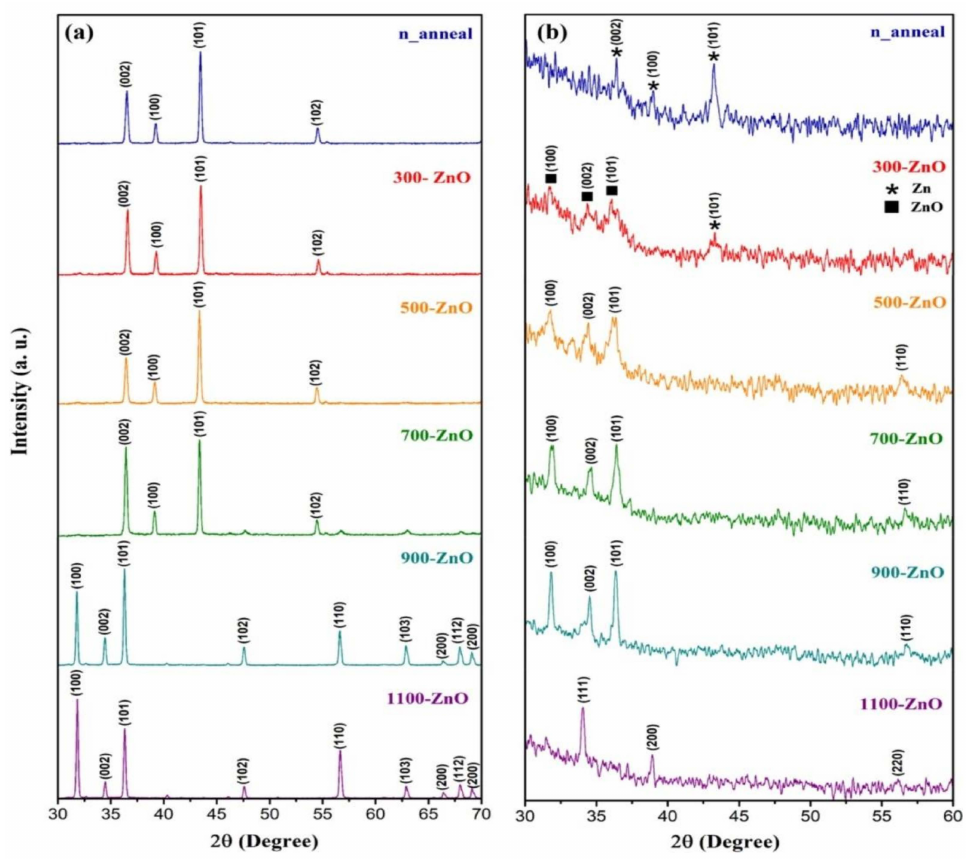
Figure 9. XRD patterns of Zn and ZnO bulk samples: ( a ) thin films [80]; ( b ) annealed at different temperatures